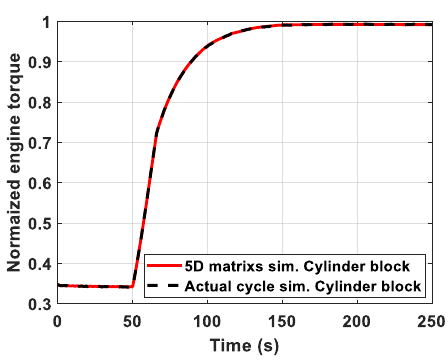
Figure 9. Engine torque time history.